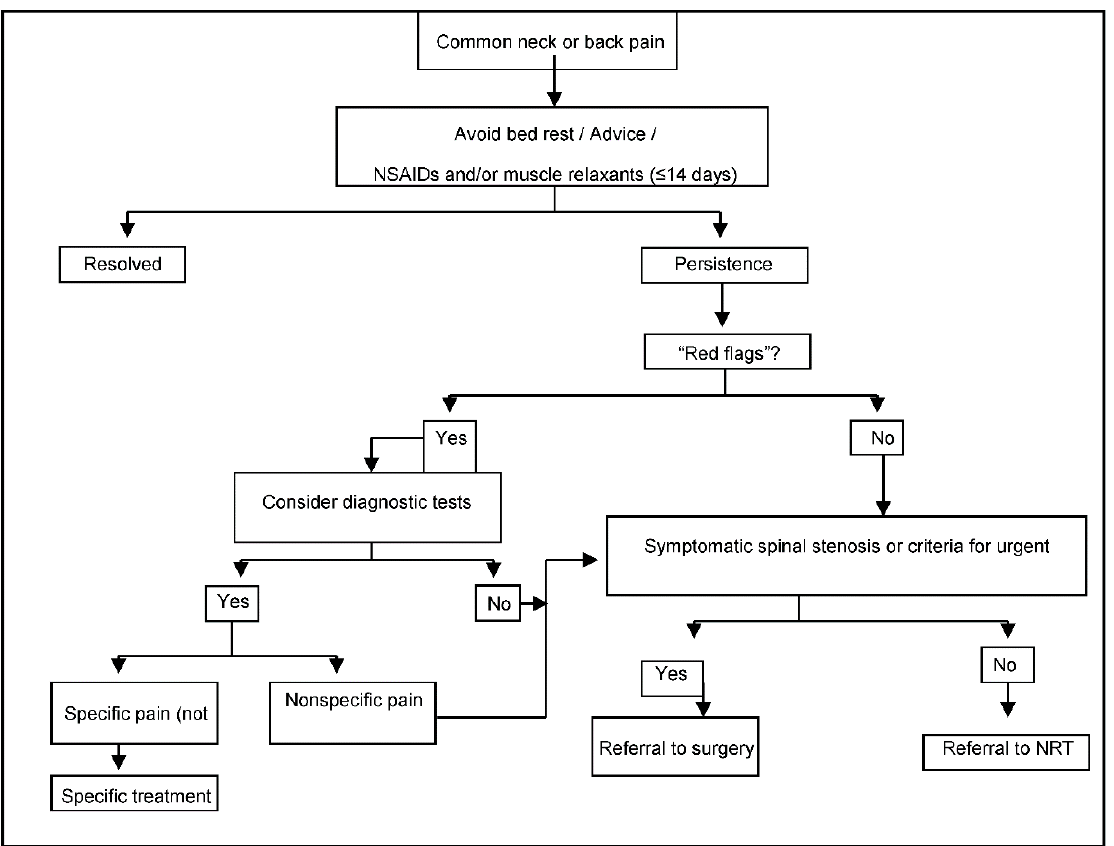
Figure 1. Referral protocol to NRT, within the Spanish National Health Service.